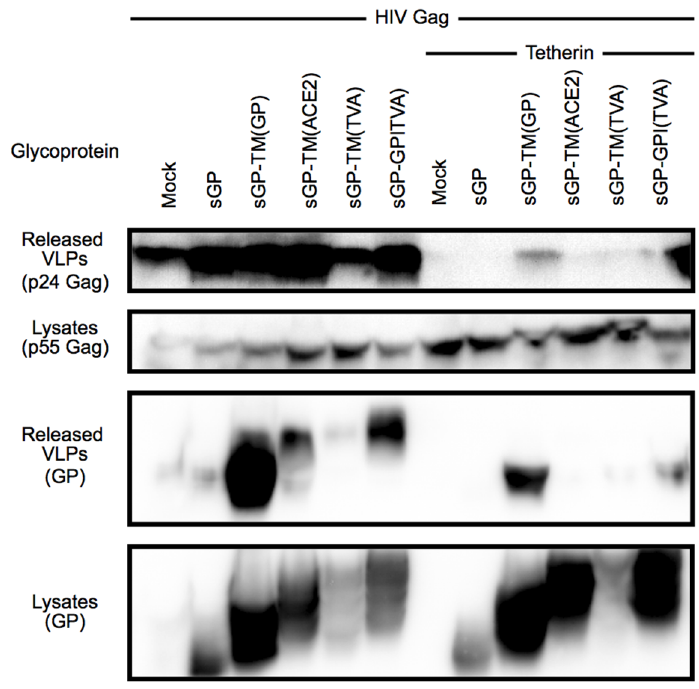
Figure 2. Chimeric sGP glycoproteins incorporate into HIV-1 VLPs but do not promote release of tetherin restricted particles. Top Panel: Released HIV-1 VLPs were analyzed by SDS-PAGE and detected by immunoblot for HIV-1 Gag (p24) in supernatant of 293T cells transfected with an HIV-1 Gag encoding vector plus chimeric sGPs with or without tetherin; Second Panel: Expression of HIV Gag. Cell lysates of the transfected cells were analyzed by immunoblot for expression of HIV Gag (p55); Third Panel: Incorporation of GPs into VLPs. The immunoblot in the top panel was stripped and probed with a polyclonal antibody against EboGP; Fourth Panel: Expression of sGP and chimeric sGPs. The immunoblot from the second panel was stripped and expression of GP was analyzed in the cell lysates. These results are representative of two independent experiments using PEI instead of Lipofectamine 2000.